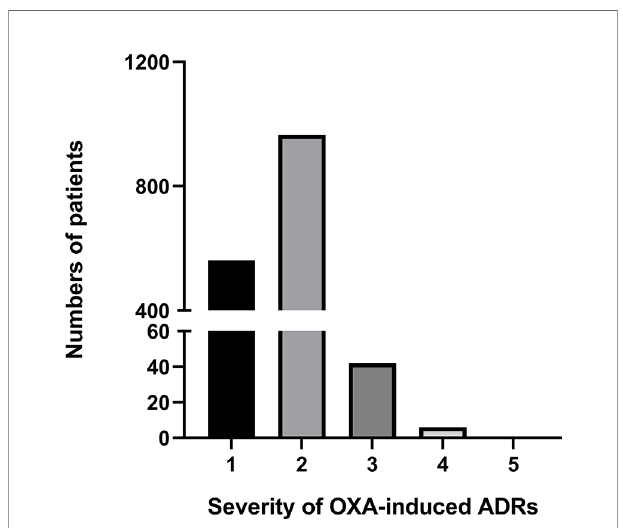
FIGURE 1 | Severity classi fi cation of OXA induced